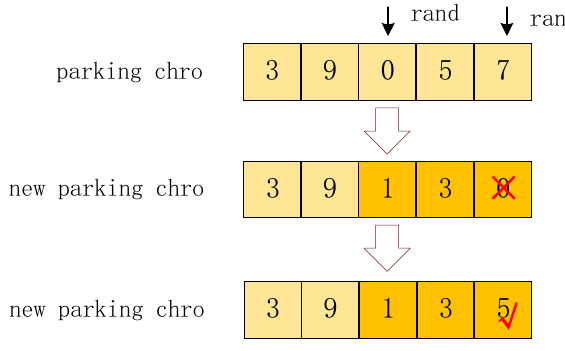
Figure 9. Mutation of the parking chromosome.